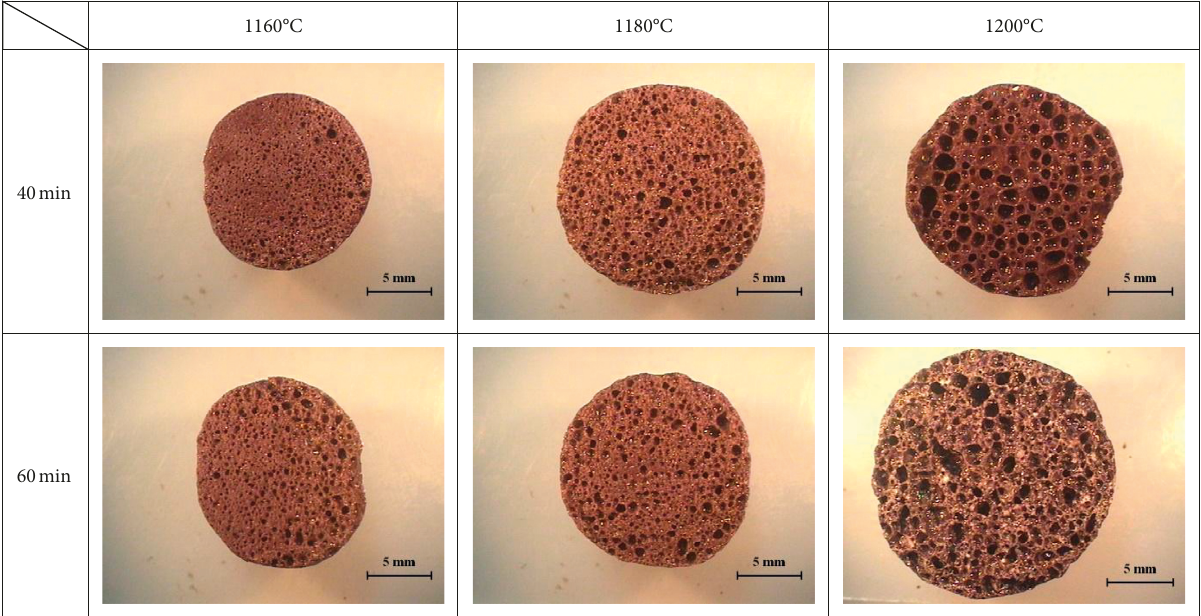
Figure 9: Microstructure image of the lightweight aggregate by normal sintering with a variation in output temperature.